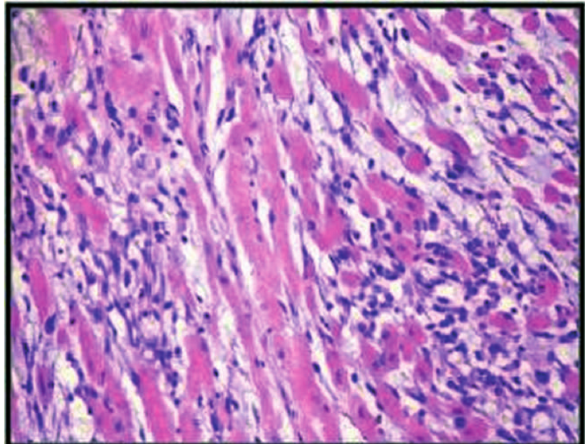
Fig. 4 - Estudo histopatológico demonstrando alterações histológicas acentuadas (Grau